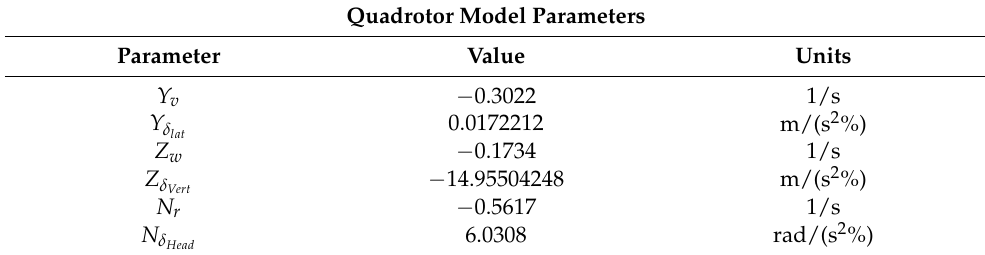
Table A1. Quadrotor model parameters used for stability analysis and the development of initial controller gains.